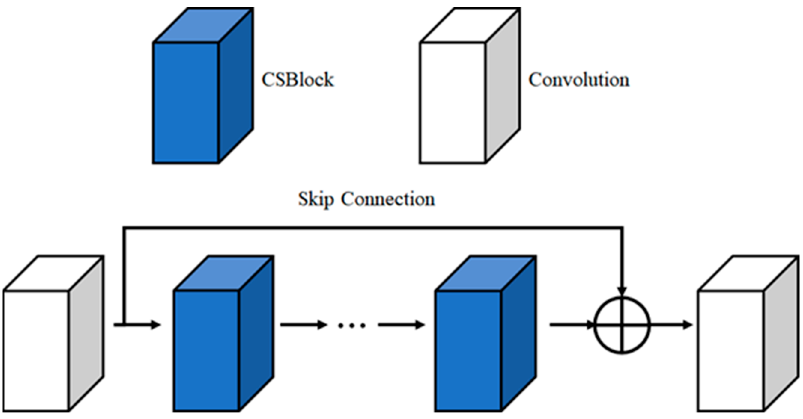
Figure 11. Attention Block.